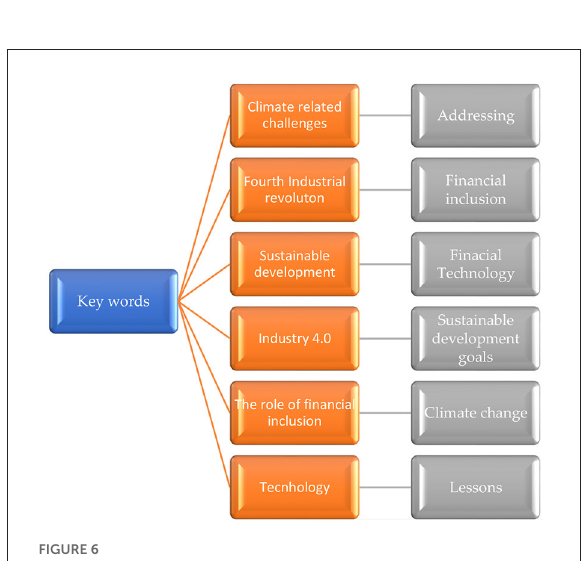
FIGURE6 Keywords used in the summative content analysis. Source: Author’s